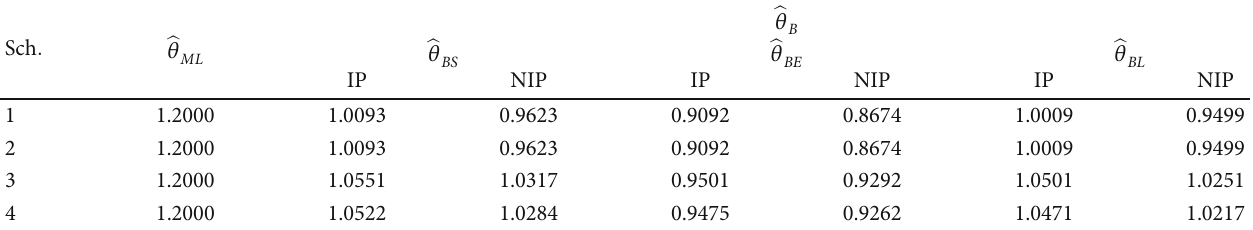
Table 9: The ML and Bayesian estimates of θ based on the di ff erent Type-II uni fi ed PHCSs from real data. Sch :